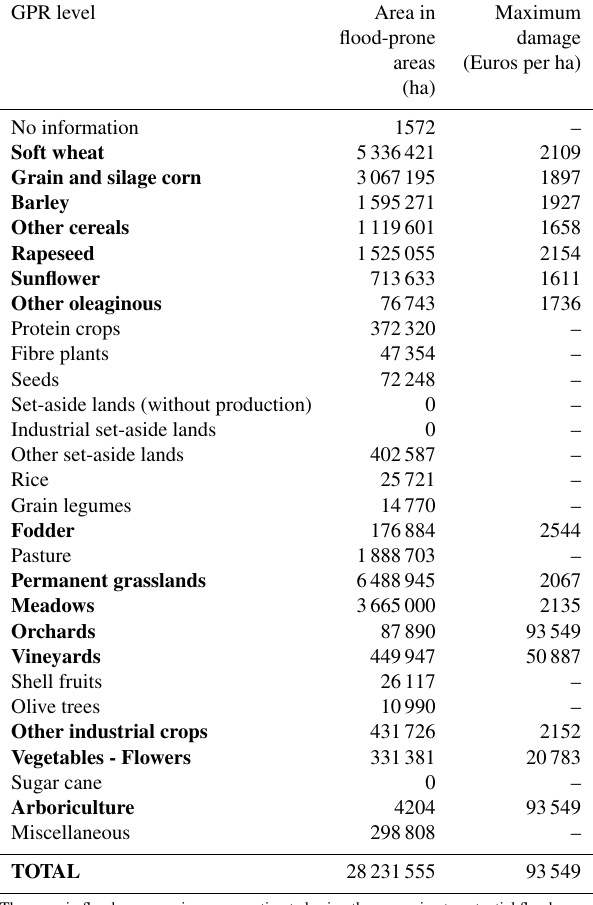
Table A2. Categories of crops in the RPG database, area in flood- prone areas, and maximum damage estimated with floodam.agri.